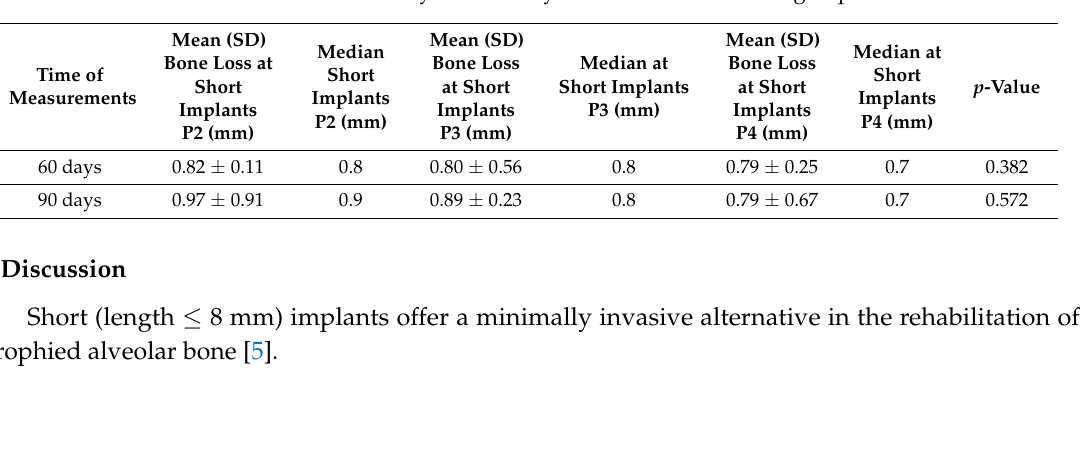
Table 5. Bone loss at 60 days and 90 days of extra-short wide ring